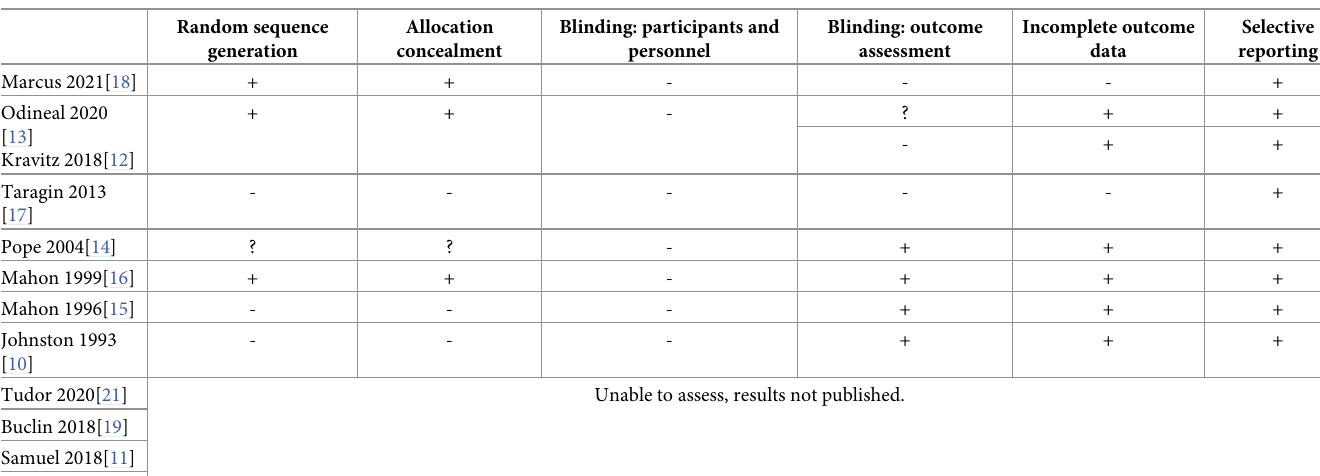
Table 1. Risk of bias of randomized trials.